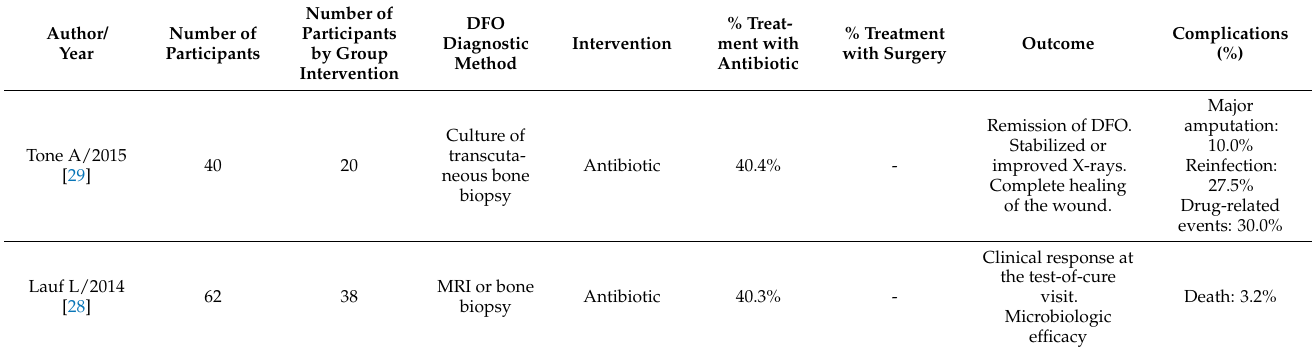
Table 1. Characteristics of studies included in the systematic